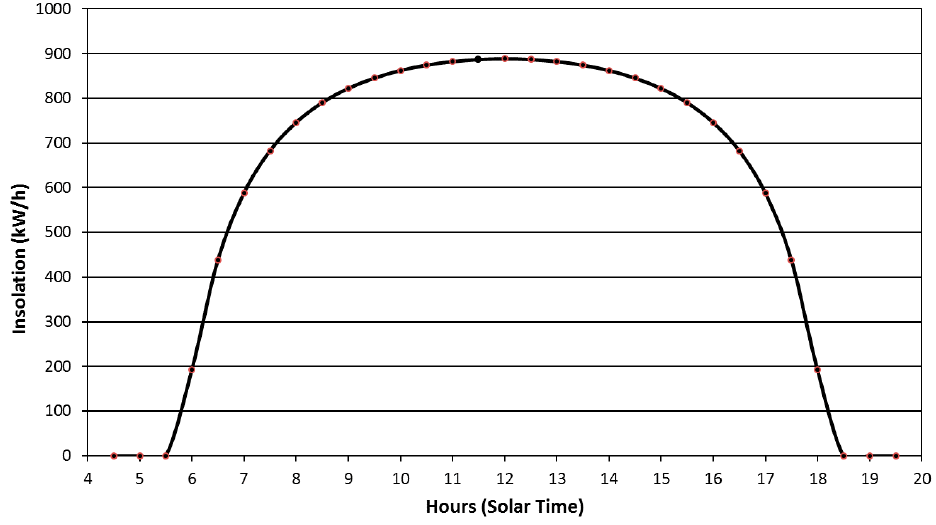
Figure 2. Insolation by time of day Beltsville, MD.